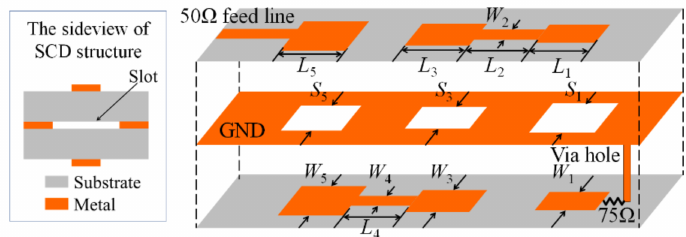
Figure 11. The 3D view of the proposed impedance transformer.